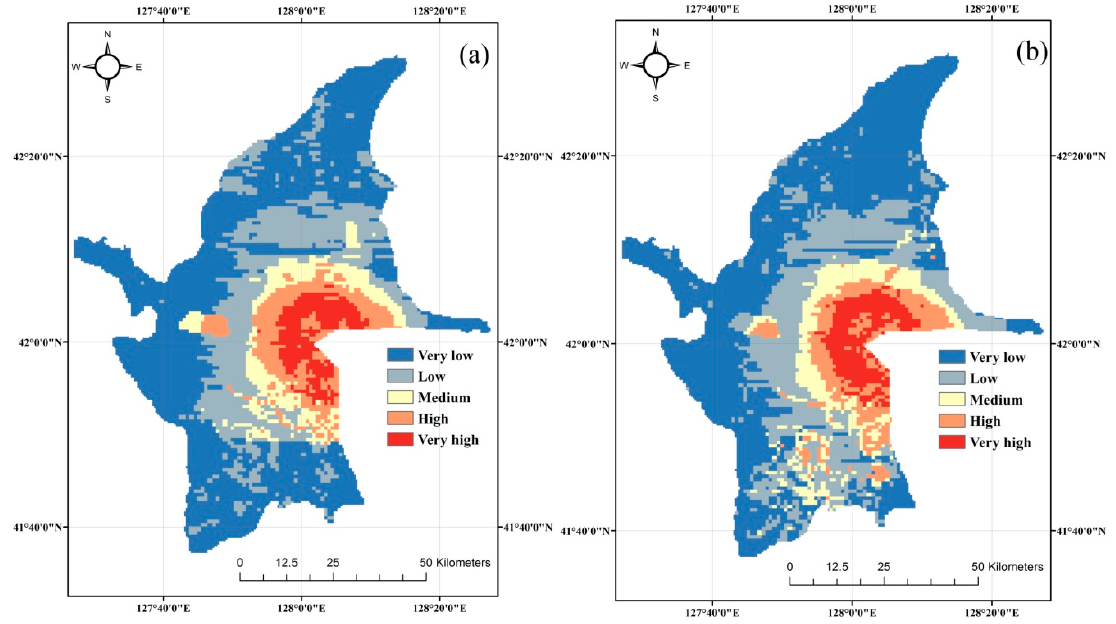
Figure 7. Seriesandparallelmodeldisasterchainsusceptibilitymapsforthechains: ( a )Earthquake-landslide, Figure 7. Series and parallel model disaster chain susceptibility maps for the chains: ( a ) and ( b ) Earthquake-landslide-debris Earthquake-landslide, and ( b ) Earthquake-landslide-debris flow.